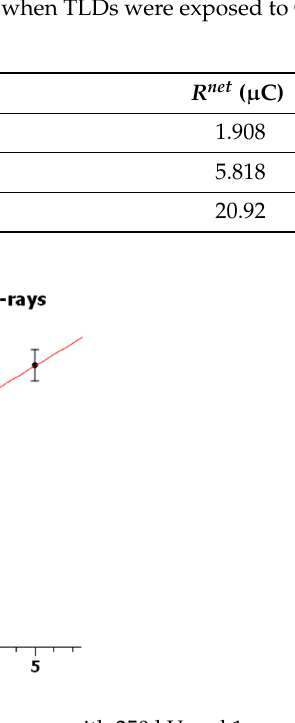
Figure 6. Plot of TLD net readings vs dose for exposures with 250 kV and 1 mm Cu filtration X-rays. Error bars represent the expanded uncertainty (k = 2) for X-rays calibration from Table 4.